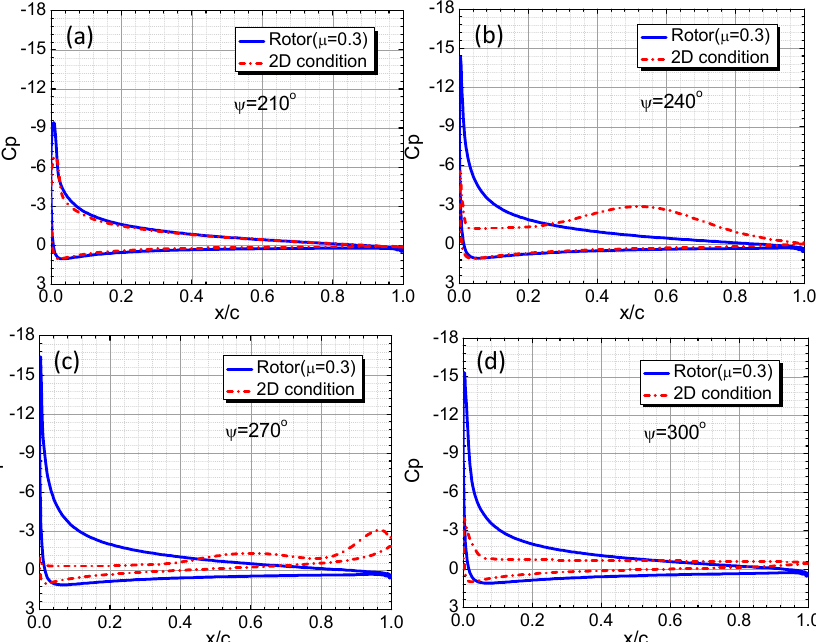
Figure 18. Comparisons of Cp distribution at different azimuths. ( a ) Ψ = 210 ◦ ; ( b ) Ψ = 240 ◦ ; ( c ) Ψ = 270 ◦ ; ( d ) Ψ = 300 ◦.